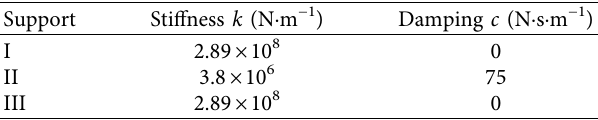
Table 2: Supports’ radial parameters.